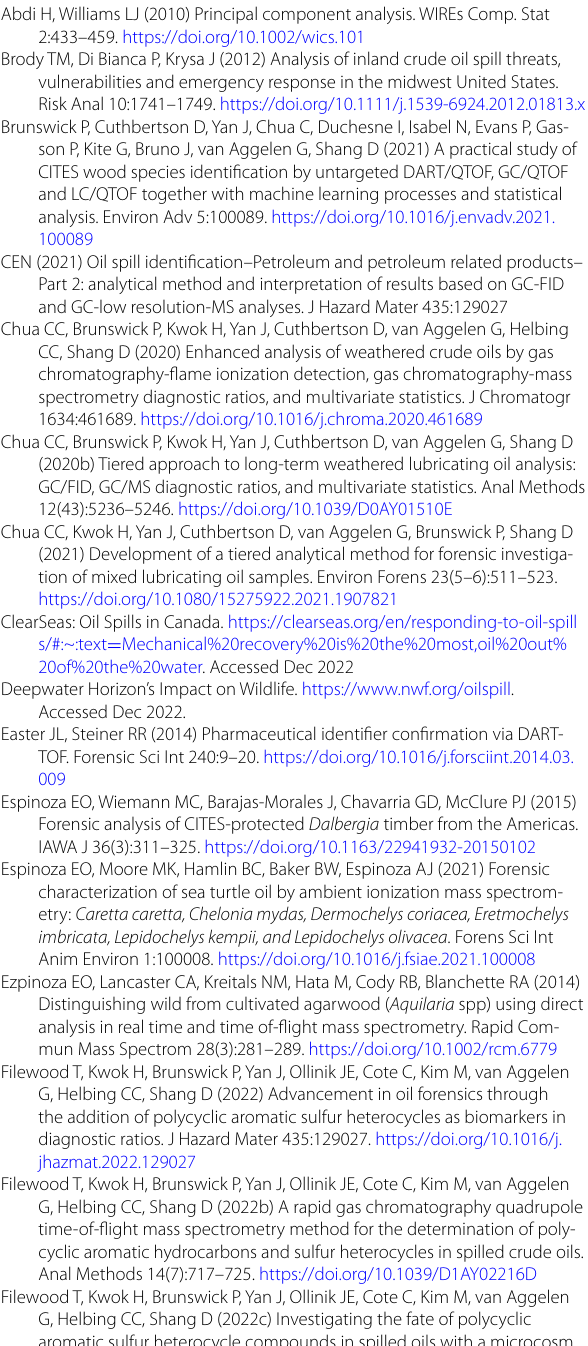
map. Figure S19. Crude Oil Heatmap. Figure S20. Jet Fuel Oil Heatmap. Figure S21. Lubricating Oil Heatmap. Figure S22. Diesel Heatmap. Figure